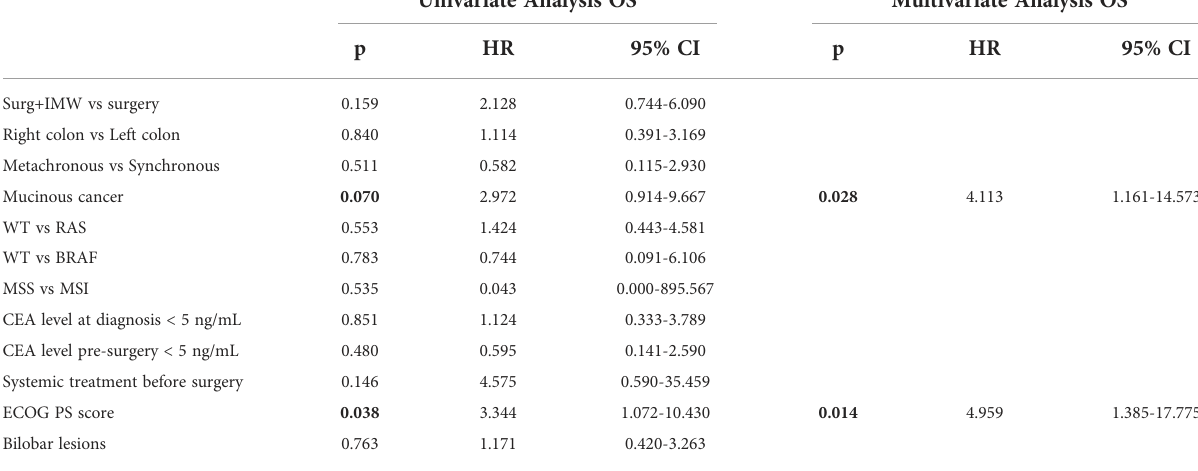
TABLE 4A Univariate and multivariate analysis for OS.